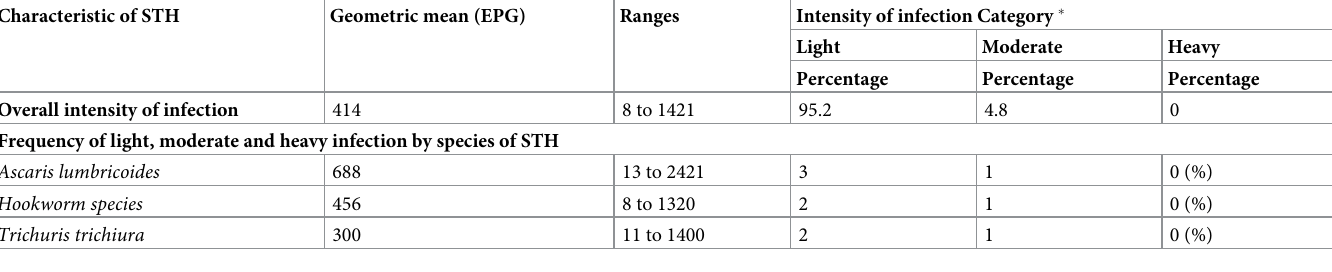
Light Moderate Heavy Percentage Percentage Percentage